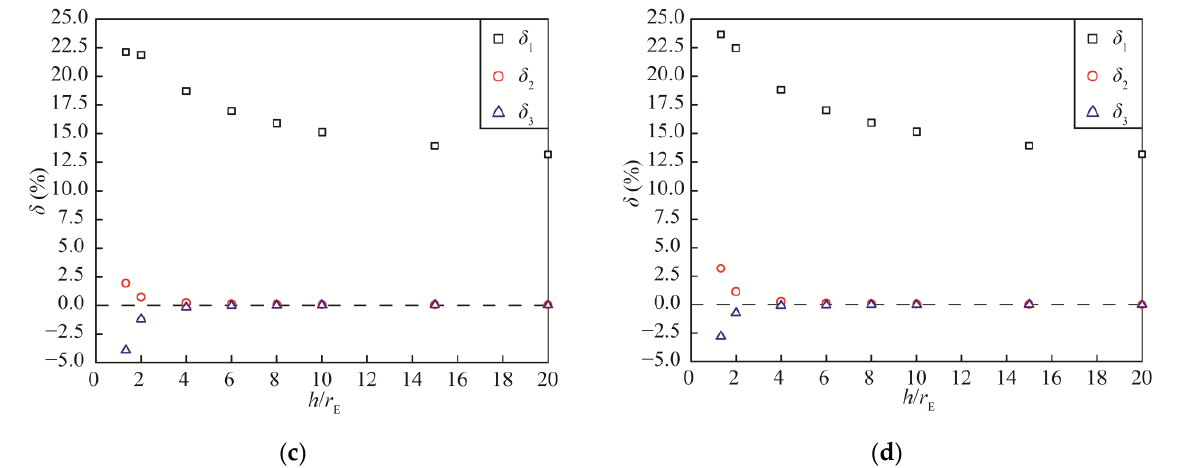
/ h r in various / H r and / k k E E R L